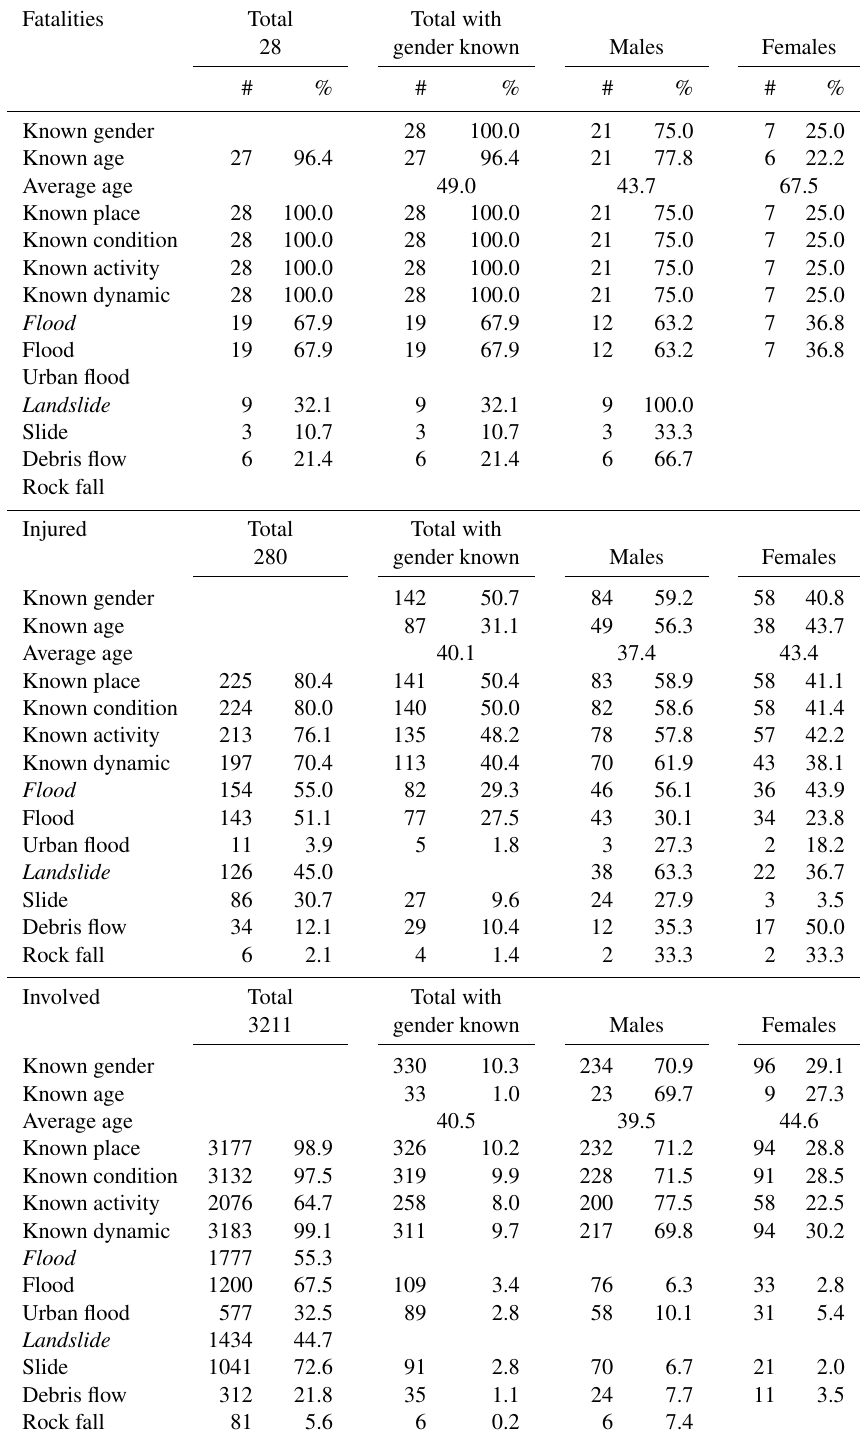
Table 2. Fatalities, injured and people involved in DHE in Calabria (period